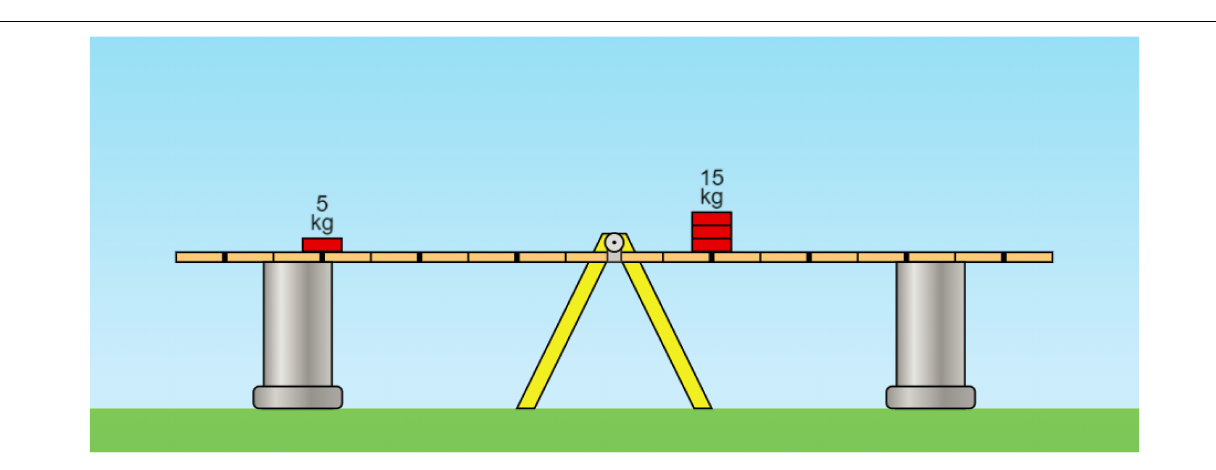
FIGURE 2 | An item of the balance beam